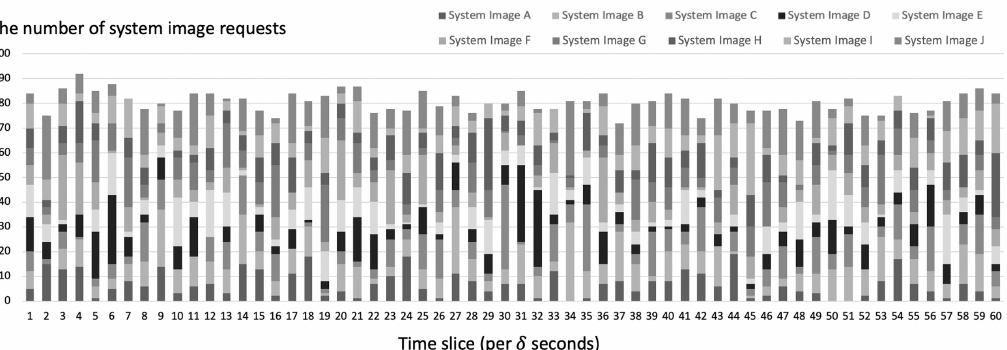
Figure 13. System image requests per time slice ( δ seconds) simulated on the server.